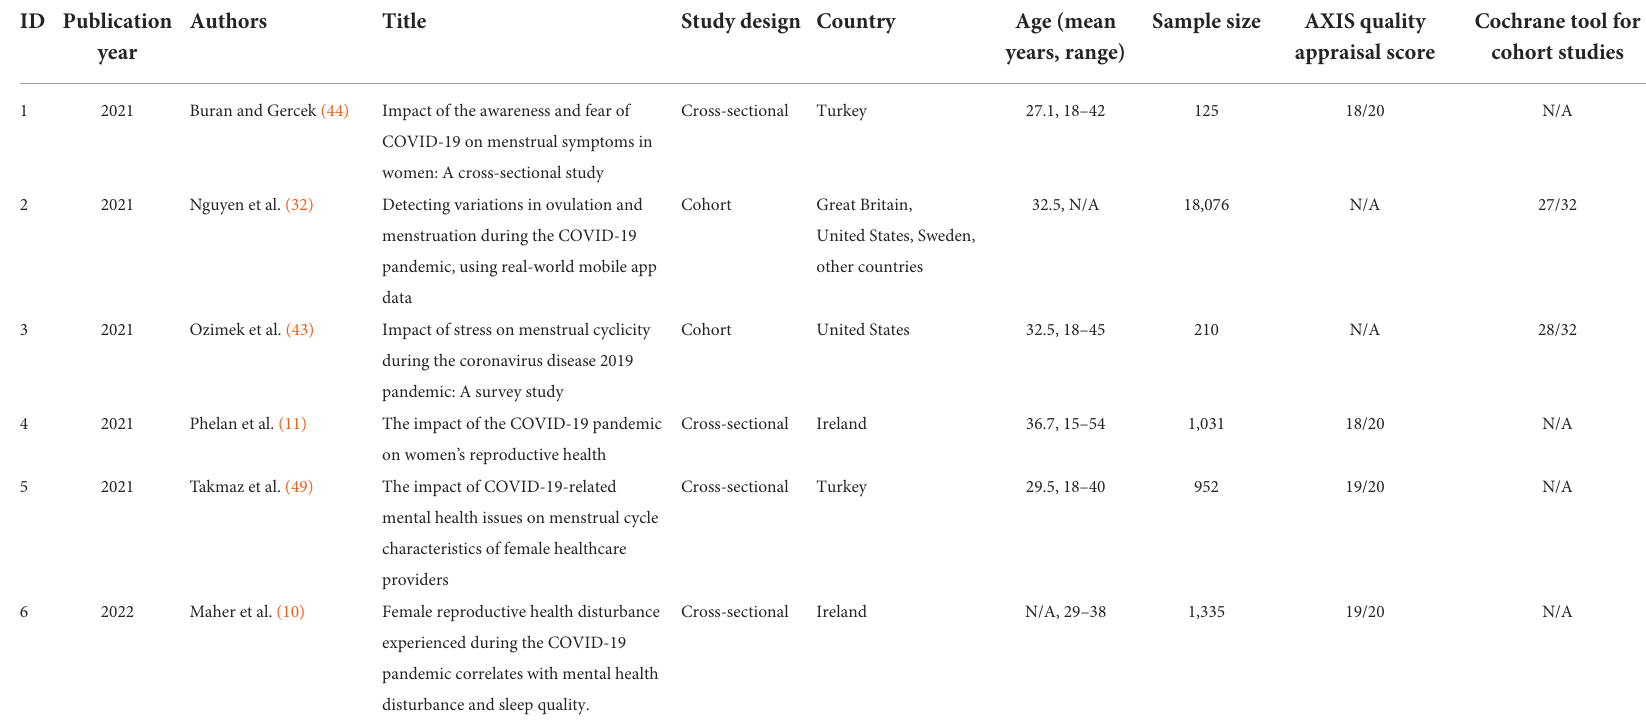
TABLE 1 Characteristics of all included